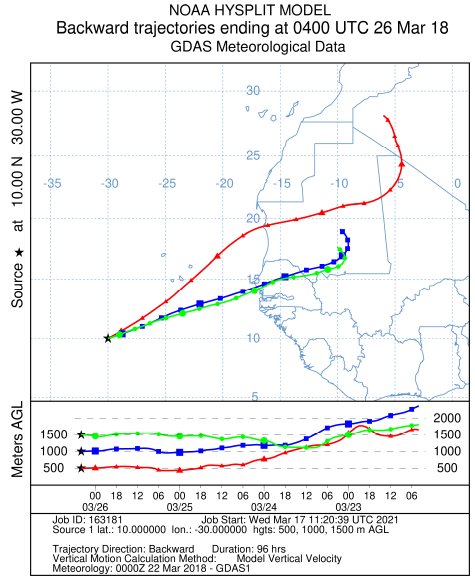
Figure 6. 96-h backward trajectories at 500, 1000, 1500 m AGL on 26 March, 2018.